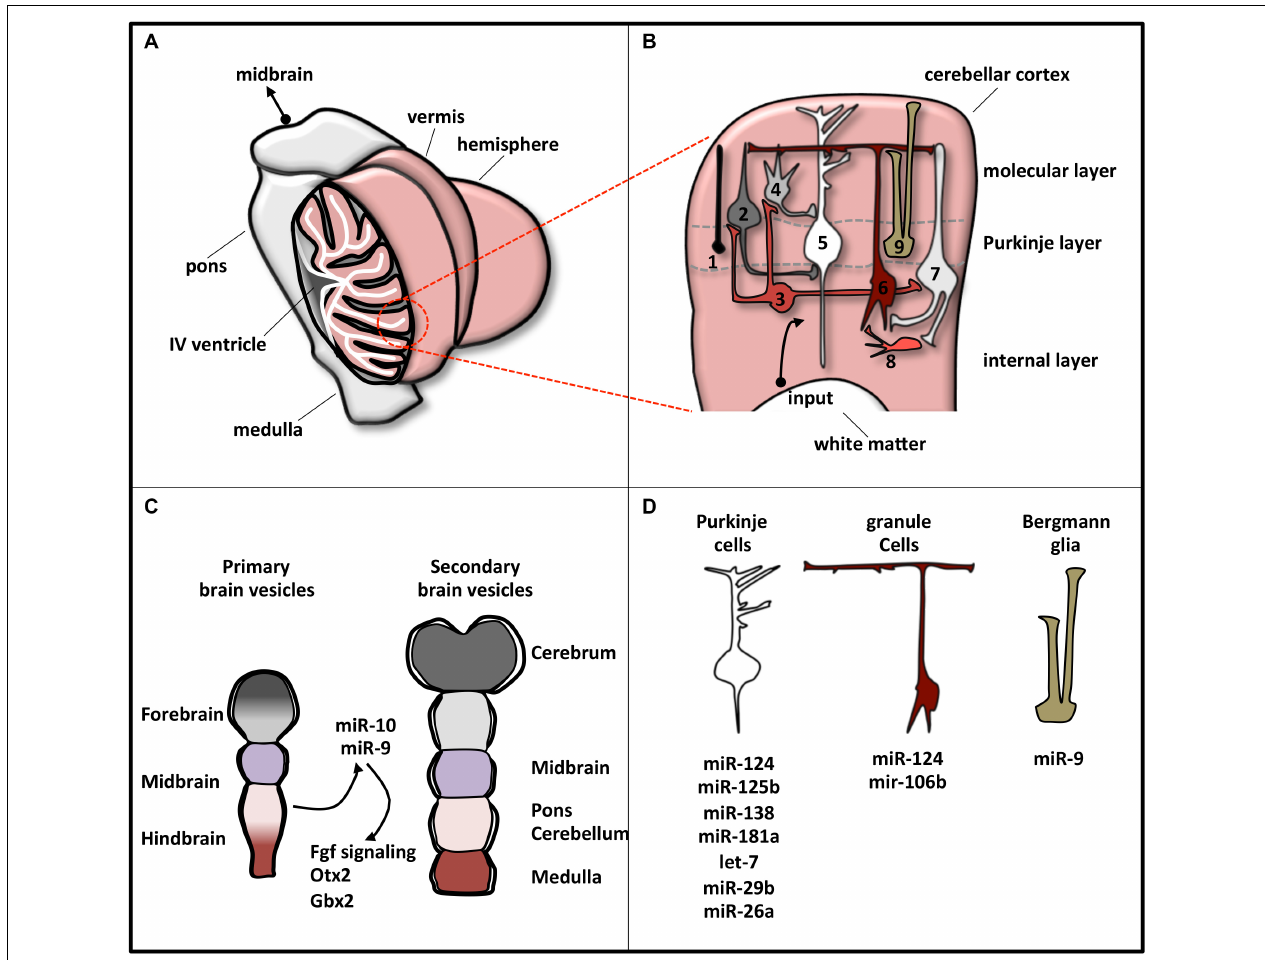
FIGURE 2 | Schematic representation of cerebellar structure. (A) The cerebellum consists of two lateral hemispheres connected by a narrow midline area (vermis). In the picture, the left hemisphere is sectioned to show the IV ventricle (which separates the cerebellum from the pons) and the lobular structure of the cortex, made of convoluted folia of gray matter supported by branching central medulla of white matter. (B) Magnification of cerebellum cortex. The eight neuronal cerebellar cell types are numbered as follows: (1) candelabrum cells; (2) basket cells; (3) Lugaro cells; (4) stellate cells; (5) Purkinje cells; (6) granule cells; (7) Golgi cells; (8) unipolar brush cell. Bergmann glia is indicated as 9. These cell types compose the three layers, indicated on the right. Input pathways from white matter include mossy and climbing fibers. (C) Brain early embryonic development. Primary and secondary vesicles identify boundaries between the prospective brain regions. miR-9 and miR-10 are expressed in the cerebellar anlage and specify the midbrain–hindbrain boundary. (D) Specific cerebellar cells express a plethora of miRNAs that regulate their differentiation or function. The most representative miRNAs expressed in each cell type are